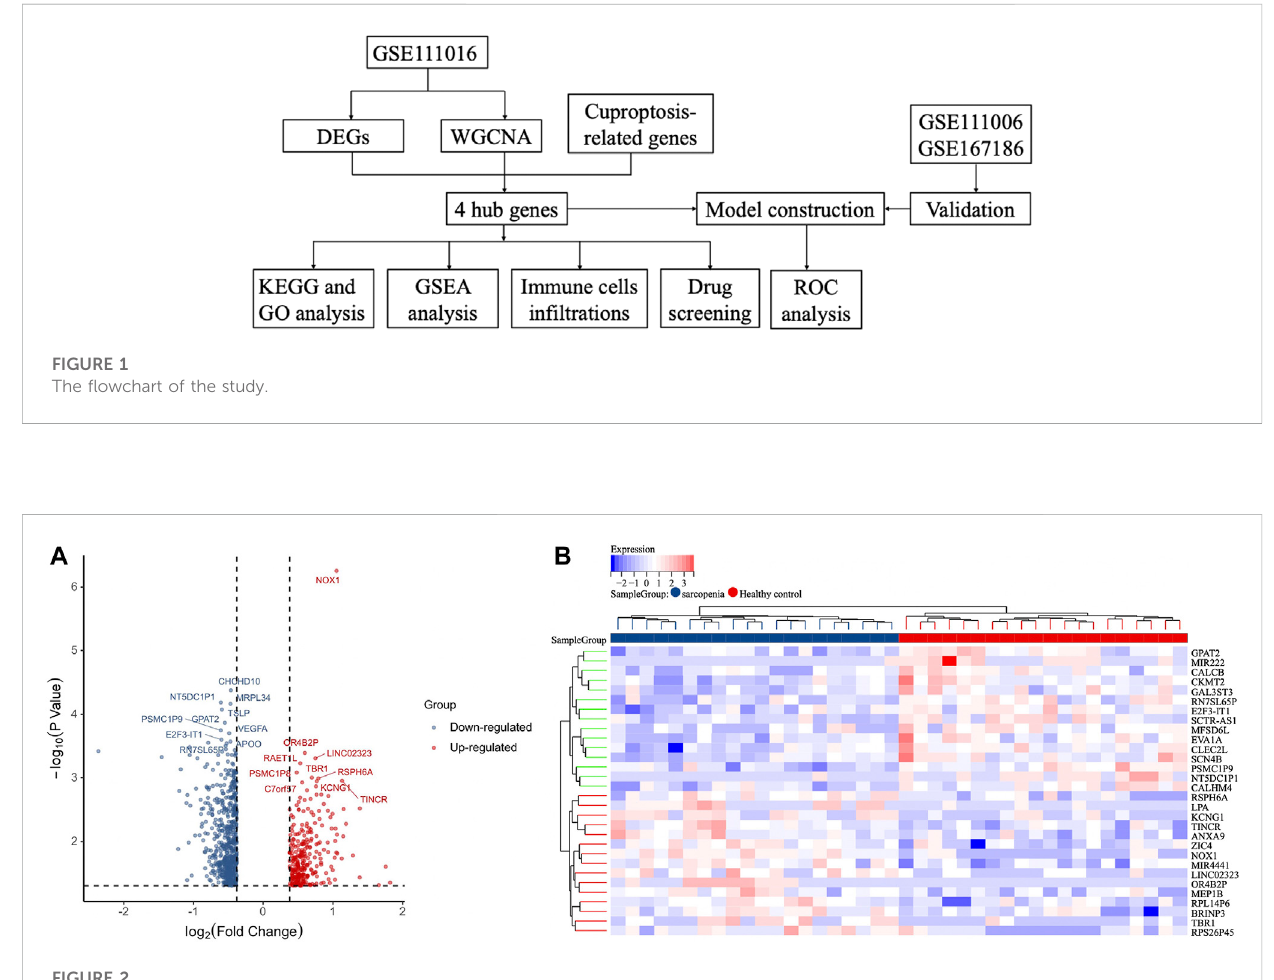
FIGURE 2 Identi fi cation of DEGs. (A) Volcano plot analysis of DEGs. Red color represents high expression, green color represents low expression. (B) The heatmap of top 30-fold-change DEGs. Red areas represent highly expressed genes and green areas represent lowly expressed genes involved in sarcopenia patients compared with healthy